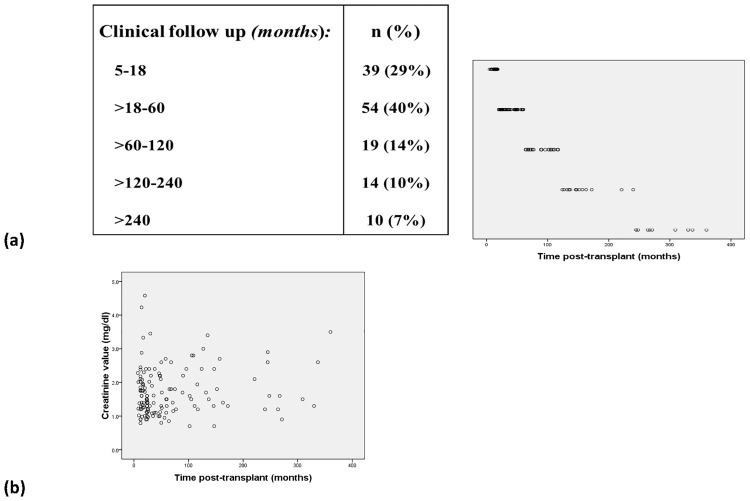
Graft function of long-term stable kidney transplant recipients.Fig 1a shows the number of transplant recipients and Fig 1b their serum creatinine levels with respect to time posttransplant.